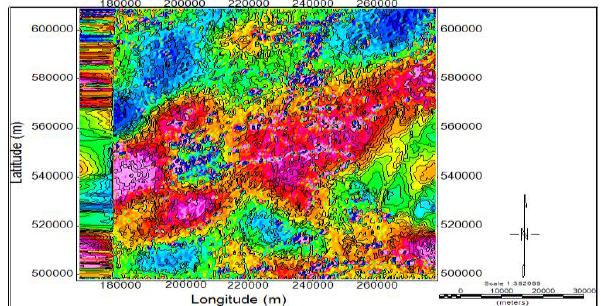
Figure 5: Aeromagnetic horizontal derivative map of the study